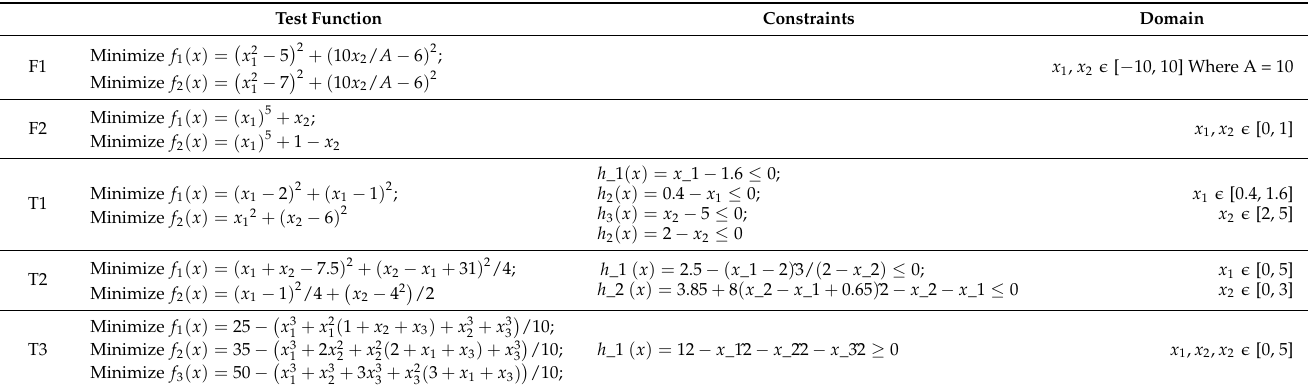
Table 1. Multi-objective test functions.